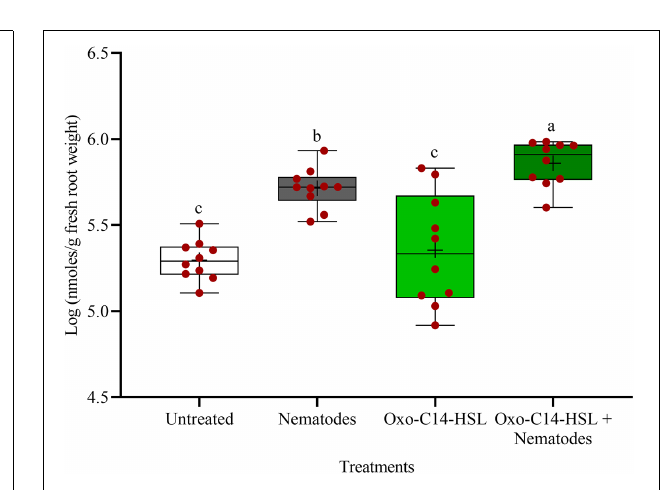
FIGURE 7 | Quantification of coumestrol-like phytoalexins in roots of oxo-C14-HSL primed and non-primed plants of soybean cv. Primus by high-performance liquid chromatography. The mean of phytoalexin content in roots in soybean roots is shown as (+) for each treatment, while the medians are shown as (–). Different letters indicate significant differences among treatments in Tukey’s test ( n = 10).